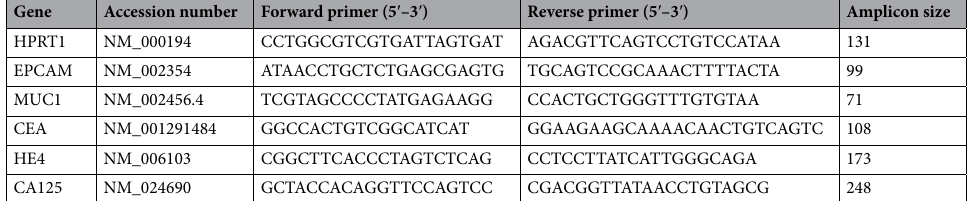
Table 2. The nucleotide sequences of primers used for the qPCR